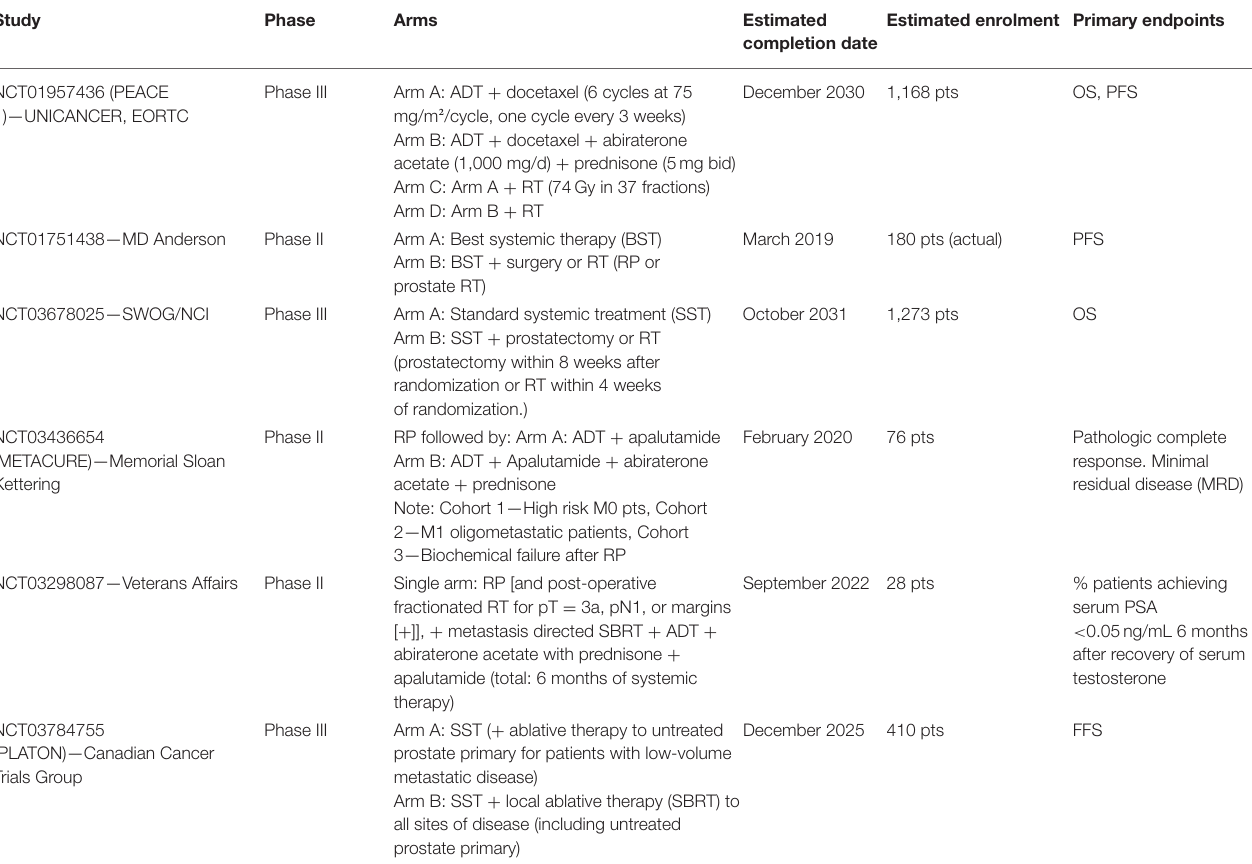
TABLE 1 | A selection of ongoing trials investigating radical treatment of oligometastatic PCa.